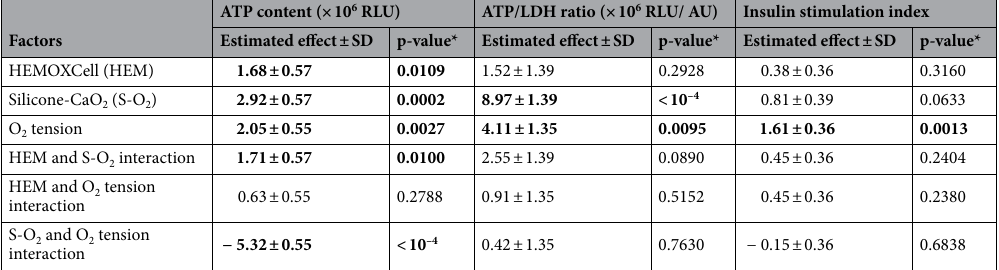
Table 2. Estimated effects of factors and interactions and their statistical significance in the screening DoE. *p-values are computed from the analysis of variance performed for each response (Supplementary Tables 1– 3). Statistical significance at 5% are highlighted in bold.